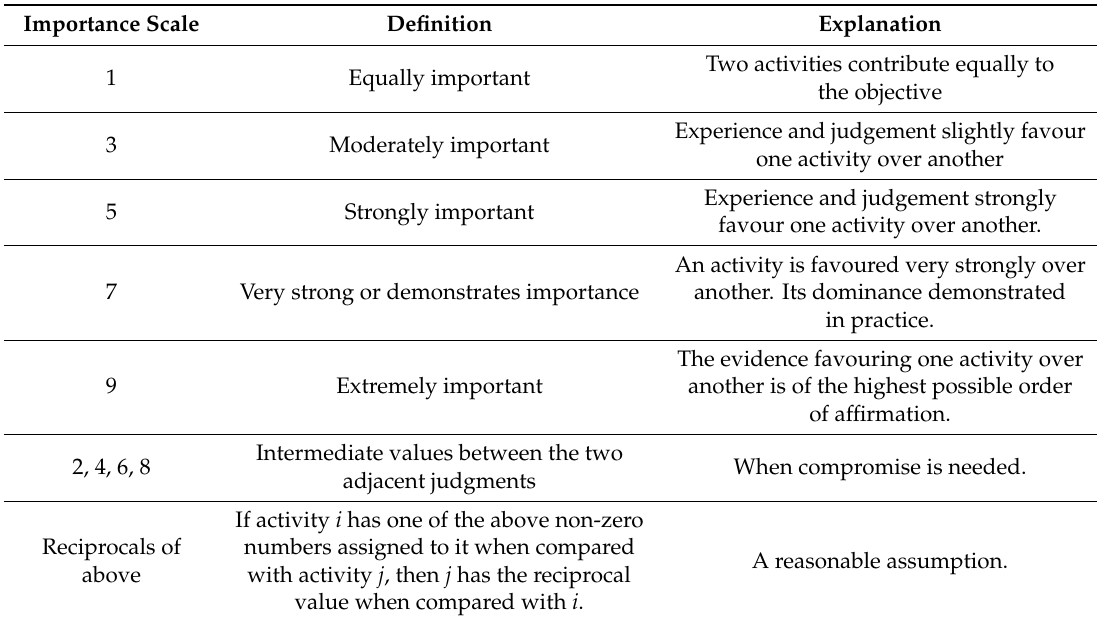
Table 2. Importance scale of pairwise comparison process [64].